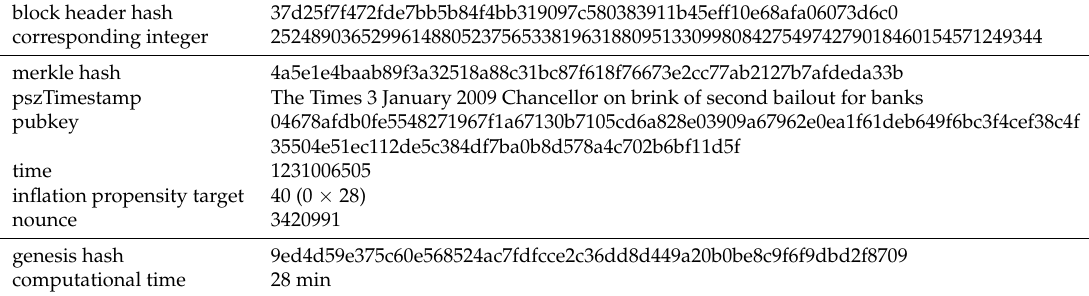
Figure 5. Proof-of-work system in the blockchain